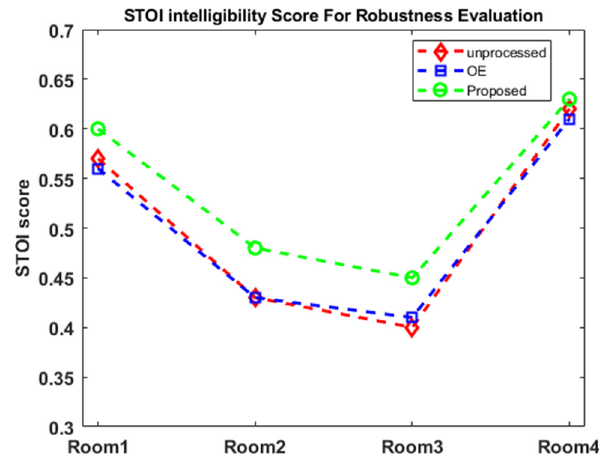
Figure 6. The STOI scores for robustness evaluation scenarios in each room for reverbed unprocessed, reverbed OE-enhanced, and the reverbed enhanced signal with the proposed algorithm. The proposed algorithm similar to the main scenarios in Figure 4 shows improvement for the STOI score in comparison to the reverbed unprocessed and OE-enhanced signals.